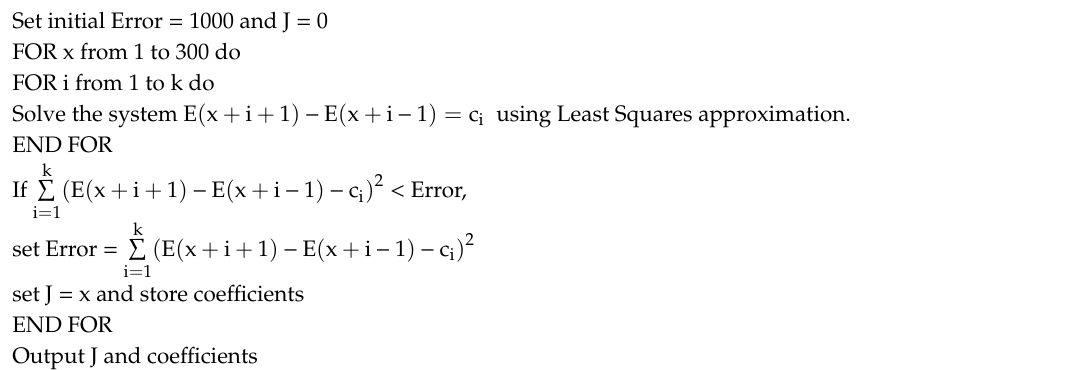
Algorithm 1. Strategy for Finding E(x) and the Quantum